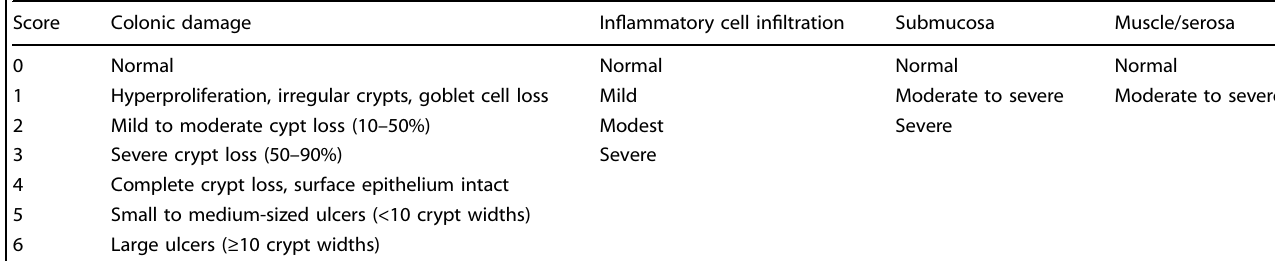
Table 1. Colonic damage score criteria used to evaluate the severity of epithelial injury, the extent of in fl ammatory cell in fi ltration and goblet cell depletion in mouse